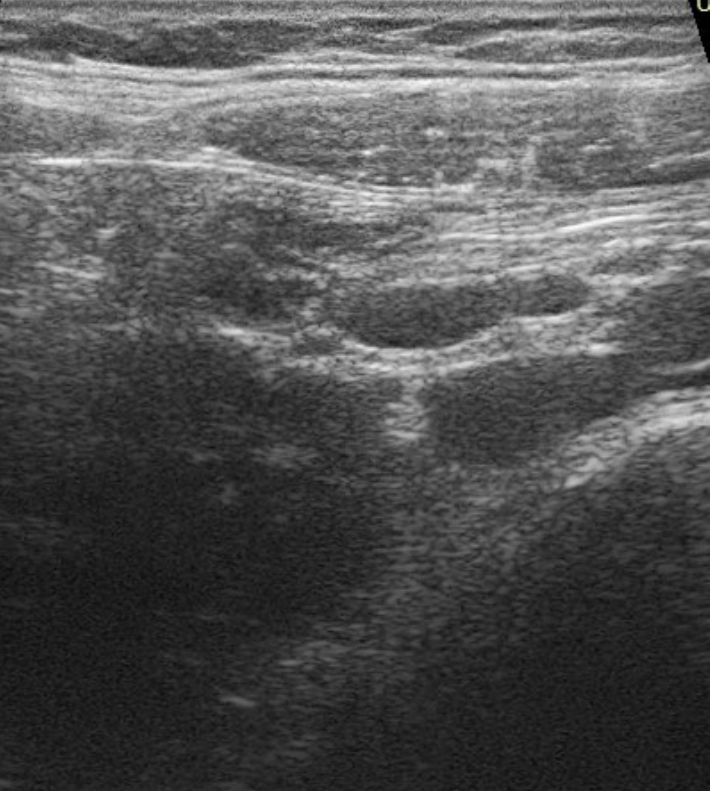
Figure 1. Increased size lymph nodes of reactive appearance in mesenteral location.